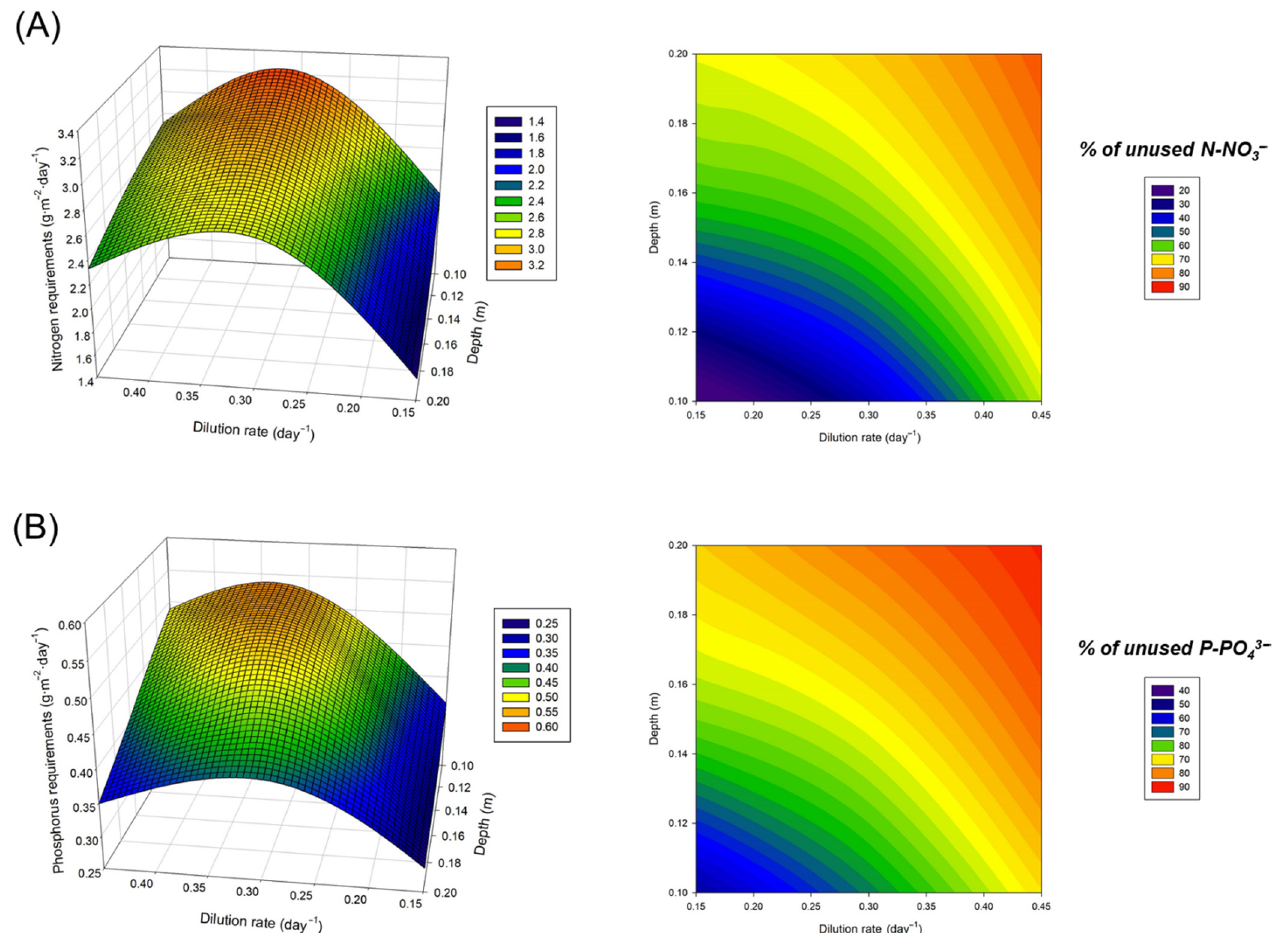
Figure 3. Effect of dilution rate and culture depth on the requirements and utilization of ( A ) N-NO 3 − and ( B ) P-PO 43 − .